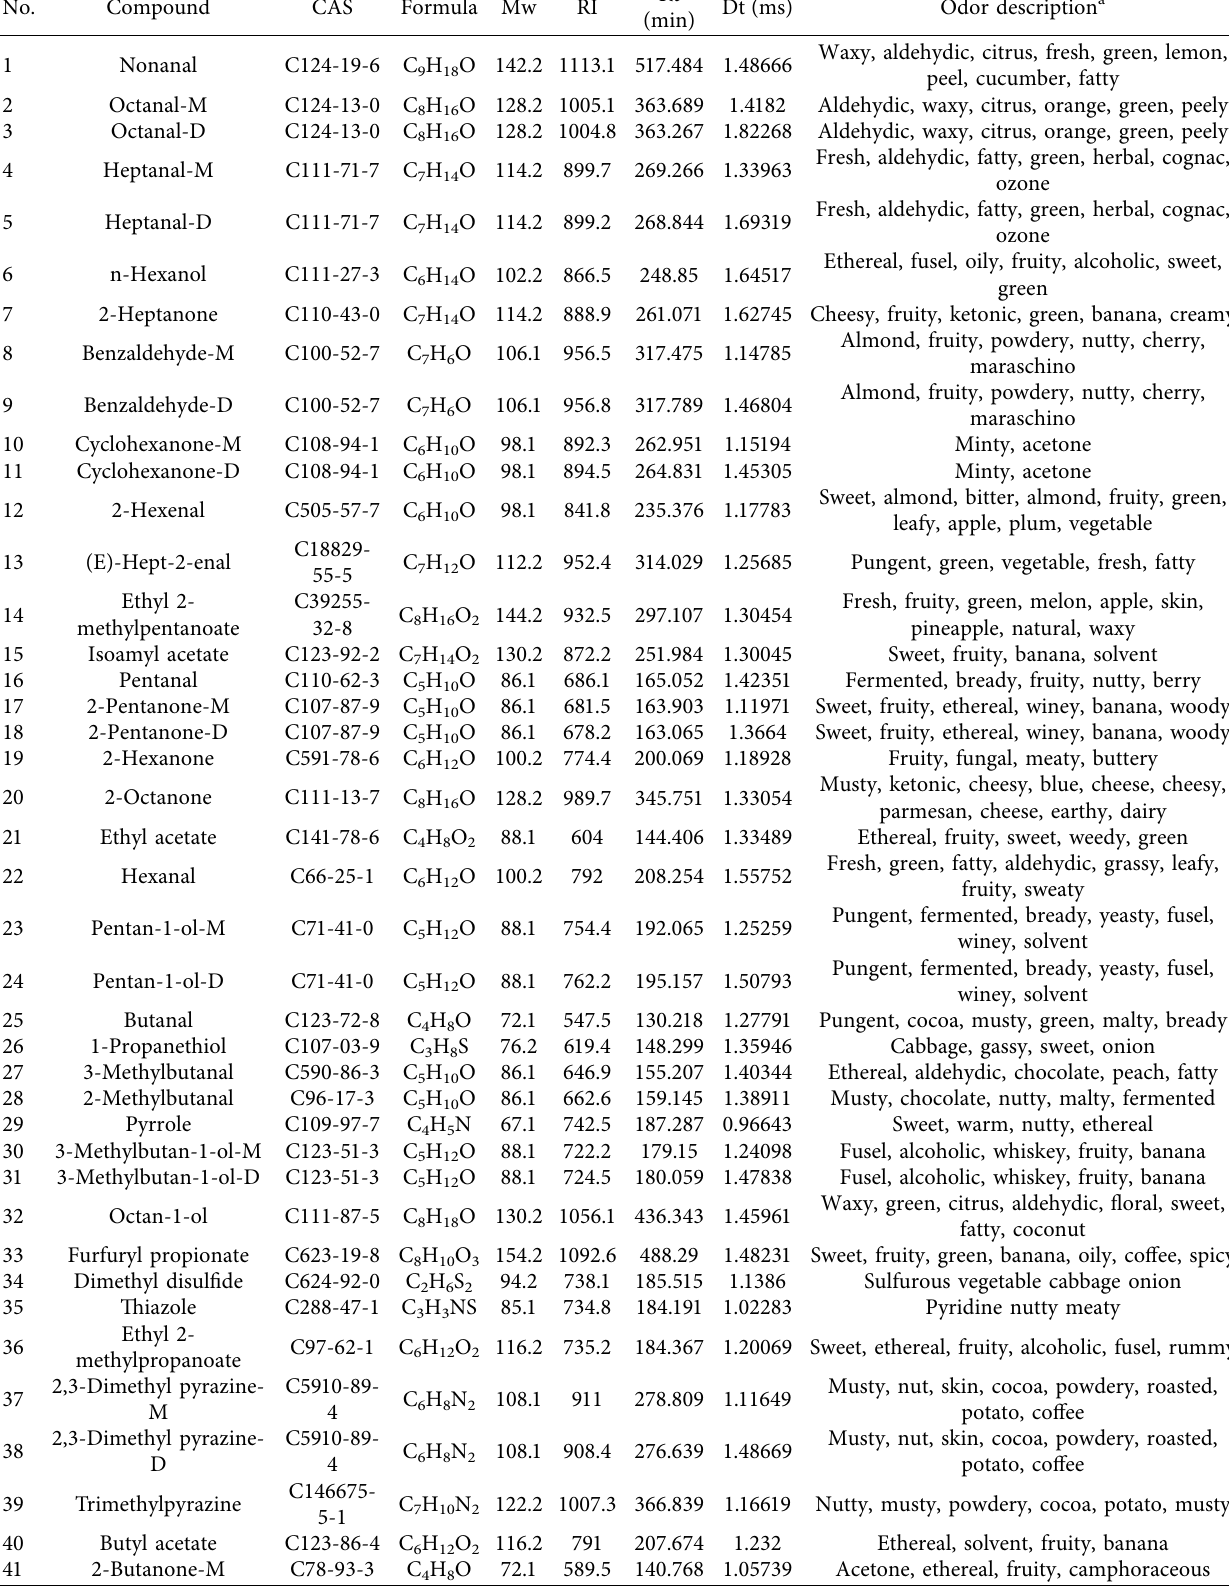
Table 1: Qualitative analysis of volatile favor